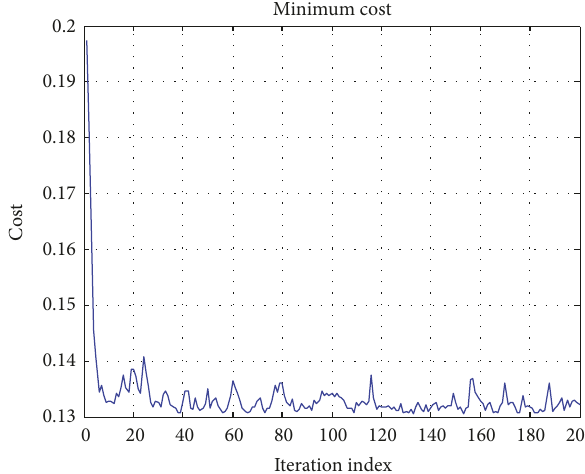
Figure 13: Simulated and measured output using (no optimized) ARMAX (balanced realization) model at flow coefficient 0.51.